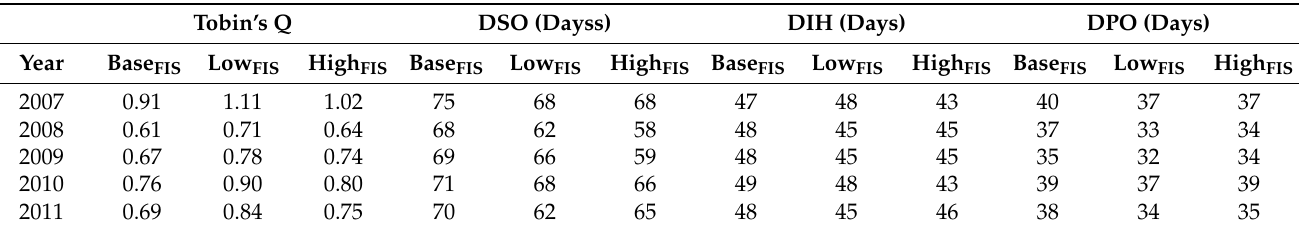
Table 4. Median of Tobin’s Q, days sales outstanding ( DSO ), days inventory held ( DIH ) and days payable outstanding ( DPO ) in low ( Low FIS ), high ( High FIS ) and base ( Base FIS ) groups of financially constrained firms. Financially constrained firms have high values of fixed investment sensitivity (FIS), non-financially constrained firms have low values of FIS and average firms are used as a reference group